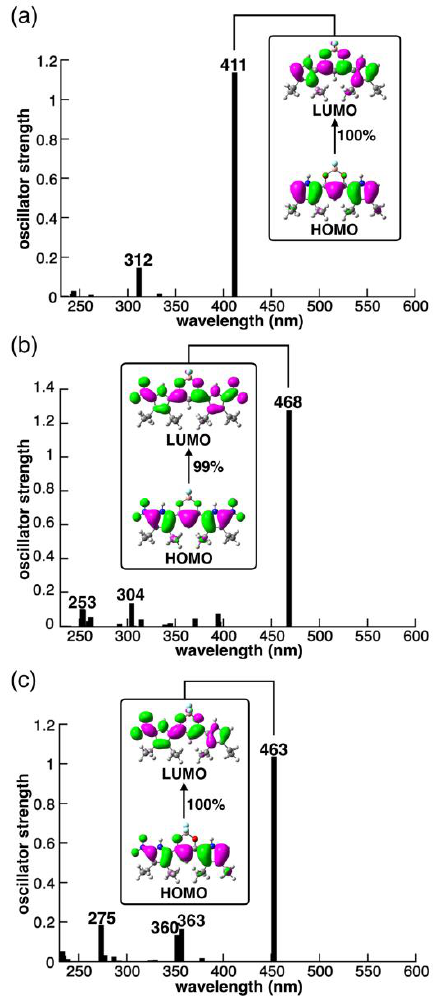
Figure 3. TD-DFT-based UV/vis absorption stick spectra of ( a ) 1b , ( b ) 2a , and ( c ) 2b with the transitions correlated with molecular orbitals estimated at CPCM-B3LYP/6-31+G(d,p) (CH 2 Cl 2 )//B3LYP/6-31G(d,p).